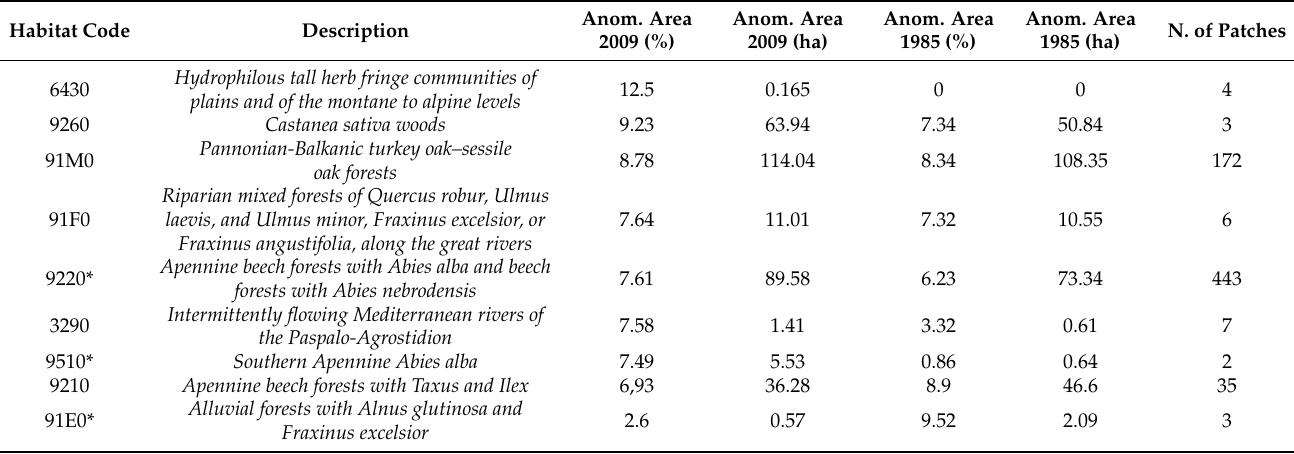
Table 4. Habitats showing the highest percentage of negative anomalous areas (habitat priority areas) computed at network level for the year 2009 and